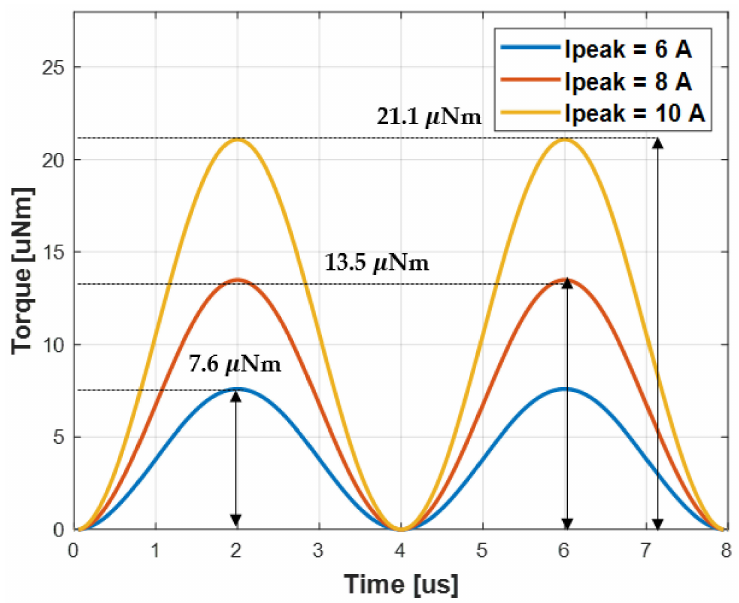
Figure 9. Torque per cycle generated in RX coil according to TX coil current size. The figure shows the torque result when the TX coil 1 differs by 60 degrees, and the torque increases in proportion to the square of the current.